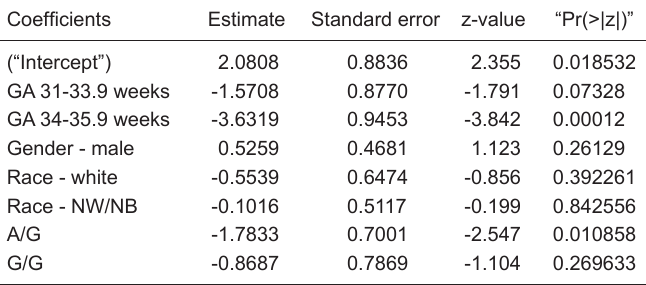
Table 4. Logistic regression analysis of the A/G 9306 polymorphism.